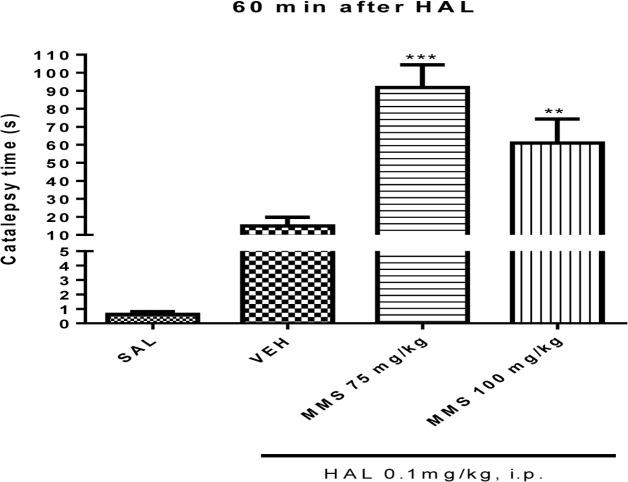
Effect of MMS (75 and 100 mg/kg, p.o.) on subcataleptic dose of haloperidol (HAL)-induced catalepsy in bar test. Values are expressed as mean ± SEM. Statistical significance: ∗∗p < 0.01, ∗∗∗p < 0.001 compared with the vehicle control (VEH) group; when not indicated the differences were not significant.